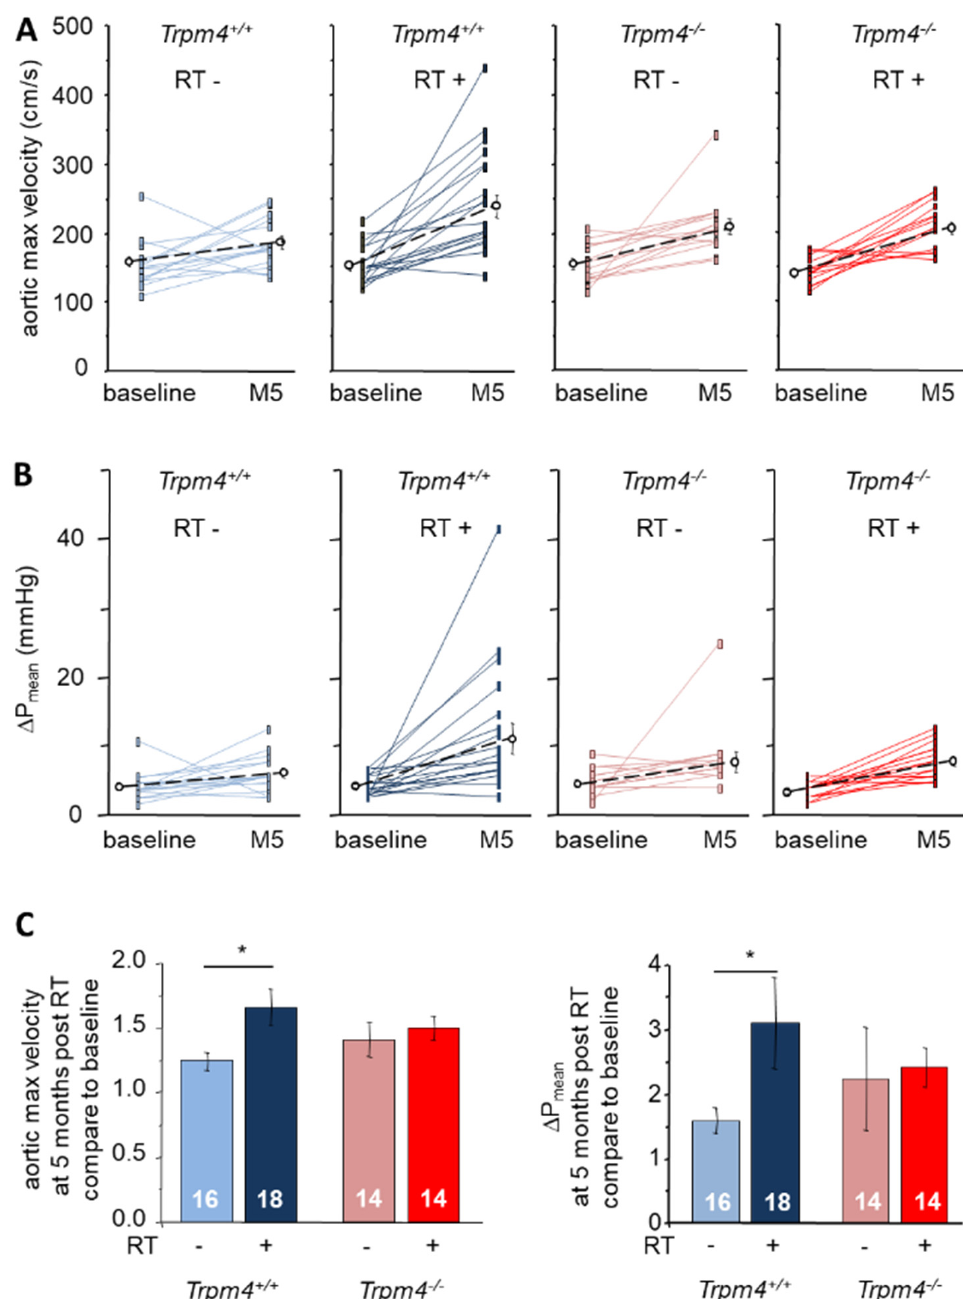
Figure 1. Evolution of the maximal aortic valve jet velocity and mean pressure gradient after radiation treatment. ( A ) Maximal aortic valve jet velocity measured at baseline and 5 months after irradiation treatment (RT+) or not (RT − ) in Trpm4 +/+ and Trpm4 − / − mice. Plain lines indicate paired data for the same mouse at baseline and 5 months. Dotted lines and open circles indicate the mean ± S.E.M for each group. ( B ) Mean pressure gradient ( ∆ Pmean) measured at baseline and 5 months as explained in A. ( C ) For each mouse, maximal aortic valve jet velocity ( left ) as well as ∆ P mean ( right ) measured at 5 months post-treatment was reported compared to that of baseline (4-month-old mice). Histograms indicate the mean ± S.E.M. for each group. In all figures, numbers in bars indicate the number of animals and * indicates a significant difference between groups ( p < 0.05).